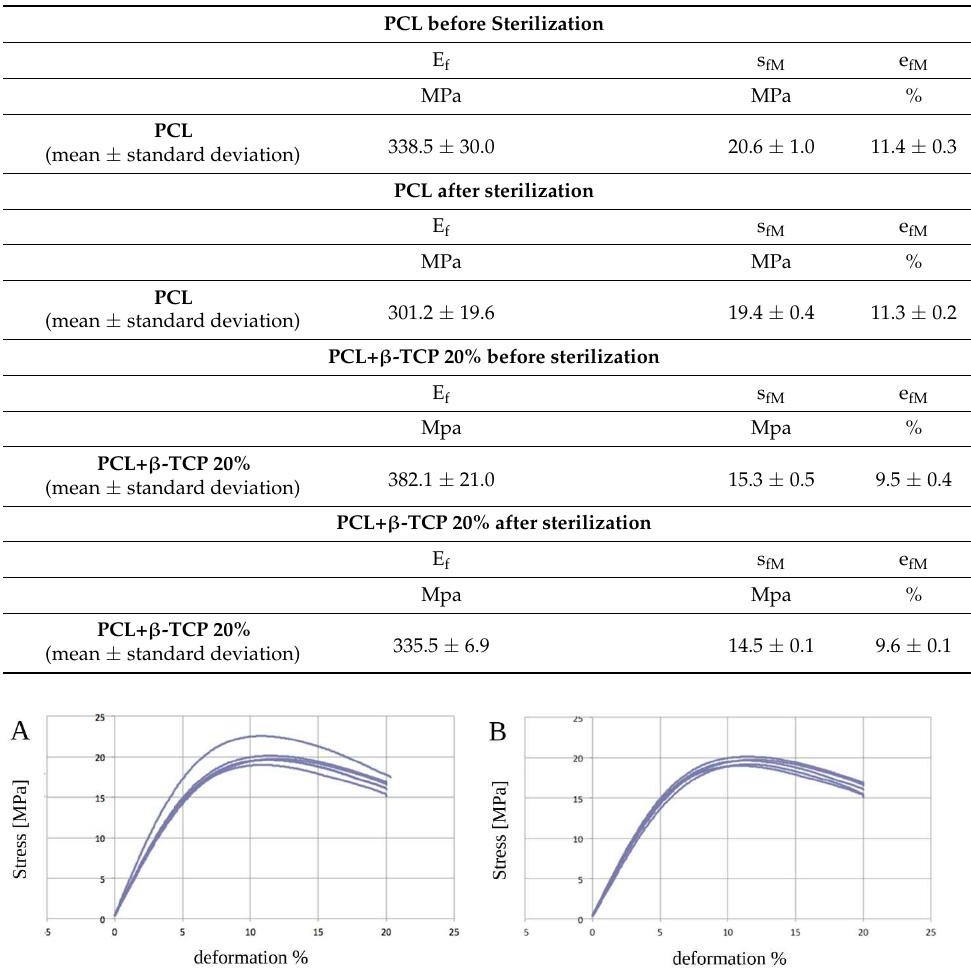
Table 3. Three-point bending Zwick Roell tests on the studied poly( ε -caprolactone) (PCL) samples. All samples were evaluated before and after the sterilization processes. The means ± the standard de- viations were calculated for five samples from each group. No statistically significant differences were observed ( p > 0.05). Similarly, the tests were conducted on the studied poly( ε -caprolactone) (PCL) com- pounded with beta-tricalcium phosphate 20% (PCL+ β -TCP 20%) samples. The means ± the standard deviations were calculated for five samples from each group. No statistically significant differences were observed ( p > 0.05).